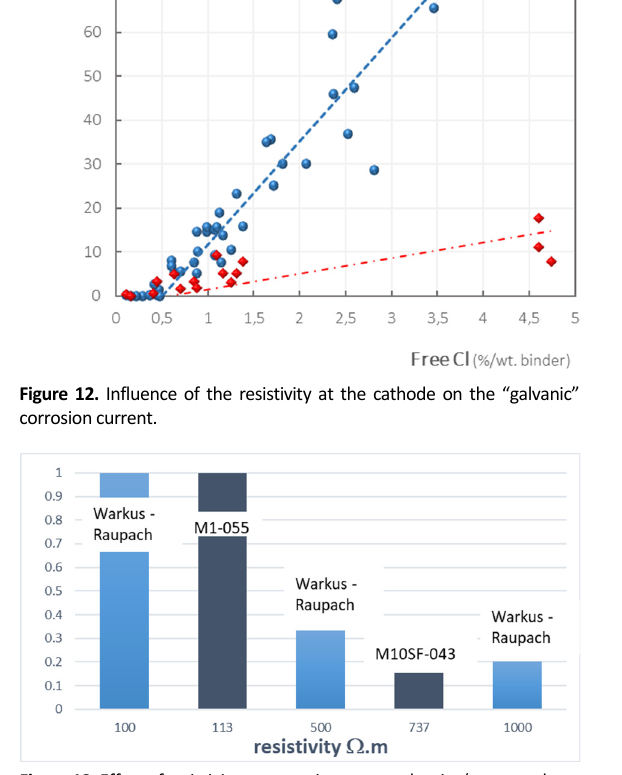
Figure 13. Effect of resistivity on corrosion current density (expressed as a ratio of the value for 100  .m concrete).